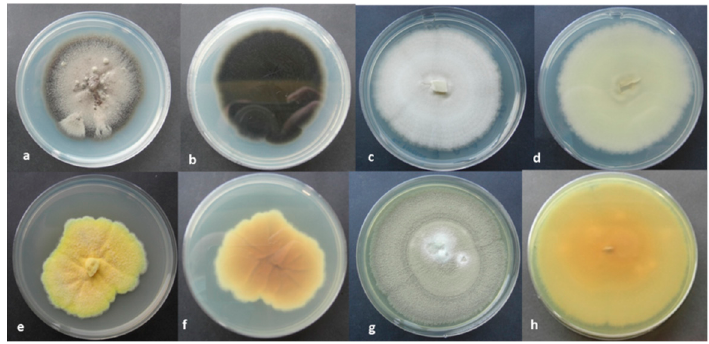
Figure 9. Fungal species isolated from hypogeum walls of the San Pietro Barisano rupestrian church on PDA media ( a , b = C. herbarium ; c , d = B. atrogriseum ; e , f = T. pinophilus ; g , h = P. chrysogenum